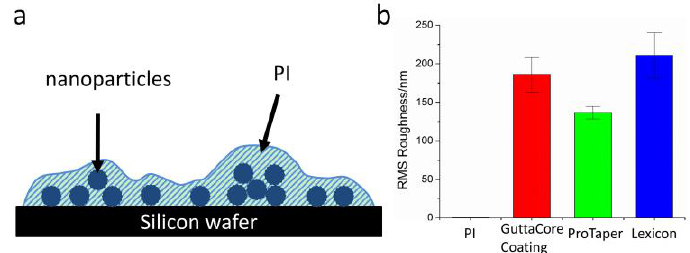
Figure 6. ( a ) Schematic illustration of a typical Gutta-percha nanocomposite scaffolds; ( b ) RMS roughness of PI, GuttaCore™ Coating, ProTaper™ and Lexicon™ samples calculated from the SPM topographical images. Note the value for PI, 1.2 ± 0.1 nm is too small to appear clearly.